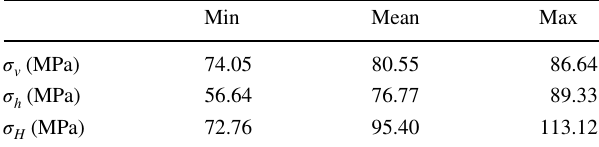
Table 11 The ranges of in situ stresses of Gachsaran formation (Kupal field) using the MEM results of well